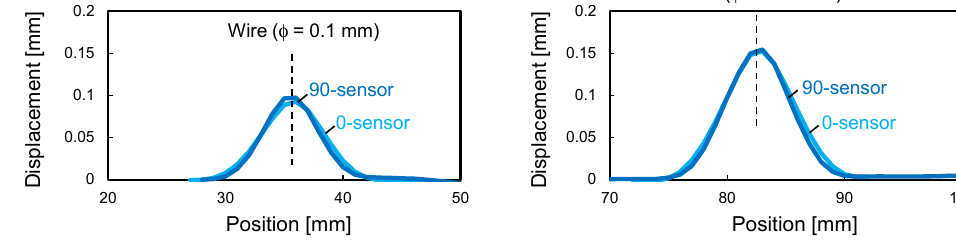
Figure 9. Sensor shape calculated from curvature.